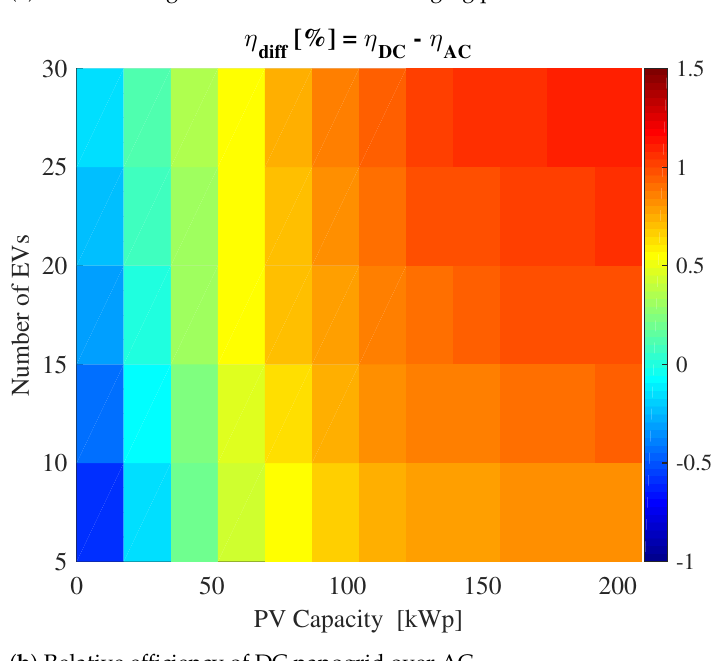
Figure 4. Relative efficiency with corresponding power